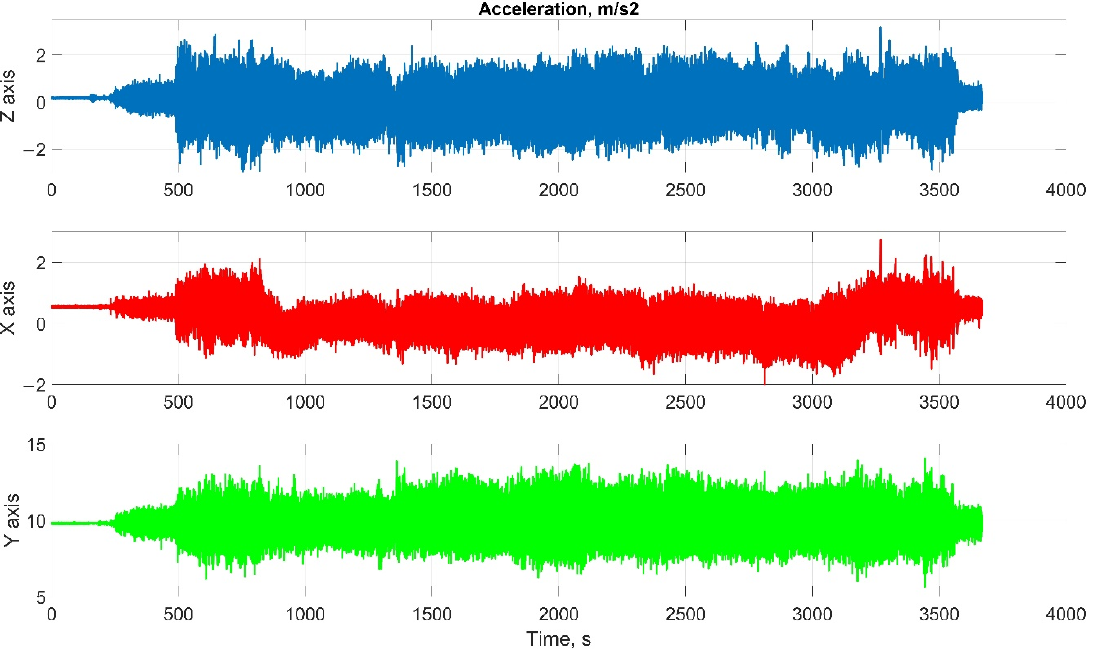
Figure 18. Accelerations in projections onto the body frame in helicopter test (X, lateral axis; Y, longitudinal axis; Z, completes the right-handed system, up axis when OXY is horizontal plane).